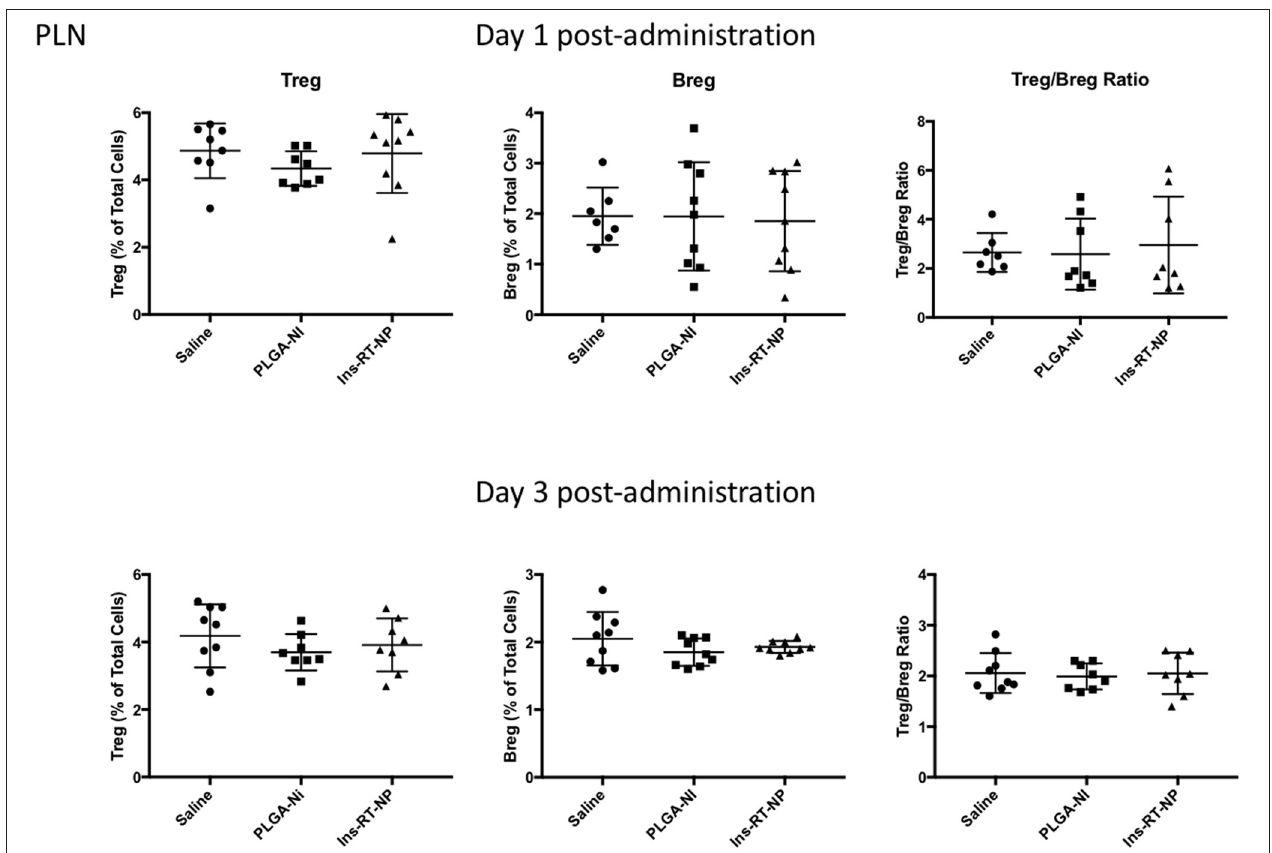
FIGURE 5 | Changes in the frequency of regulatory lymphocyte cell populations inside the PLN of NOD mice following acute microparticle administration. Animals from the acute study cohort (See timeline in Figure 4A ) were euthanized at 1 or 3 days following test article administration. Single cell suspensions from resected PLN were then assessed by flow cytometry for Treg and Breg frequency. There were no discernible differences in the Treg or Breg frequency in the PLN among the mice of the three treatment arms at 1 or 3 days following microparticle administration. Similarly the ratios between Treg and Breg cells were unaltered. Data are combined from the outcomes in two independent animal cohorts examined at different times in the study ( n = 7–9 per arm).